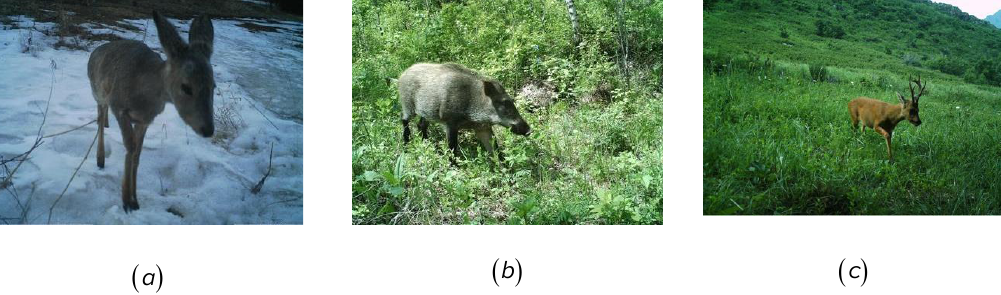
Figure 2. Wildlife monitoring images: ( a ) Capreolus pygargus ; ( b ) Sus scrofa ; ( c ) Cervus elaphus